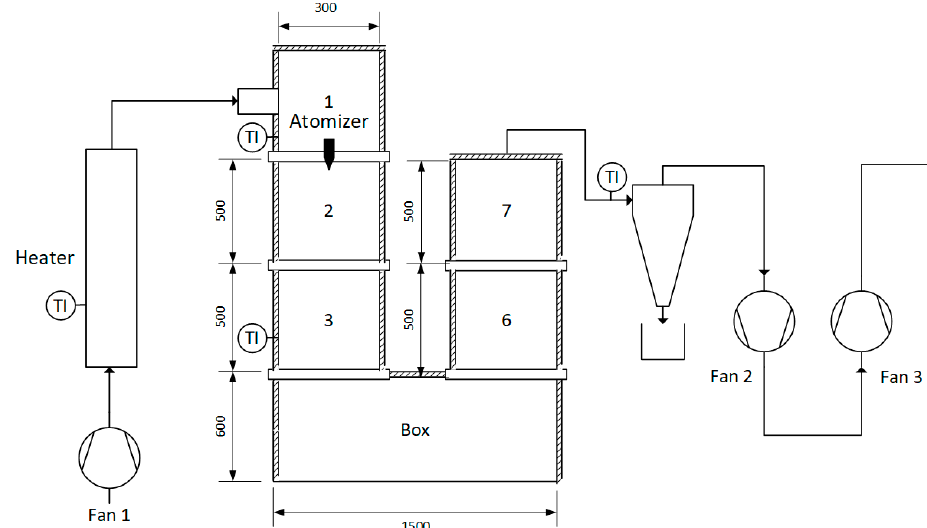
Figure 1. Spray dryer with cylindrical connections (Design 1: four-inch connection, Design 2: six-inch connection). All unit are in mm unless stated otherwise.